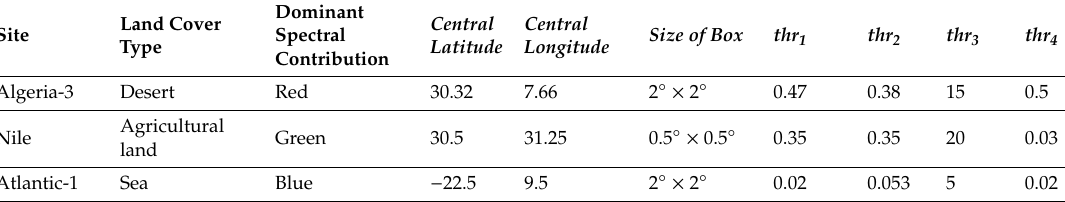
Table 4. Evaluation sites where band-adjusted (homogenised) time series were generated along with spectral characteristics and thresholds for the filtering of SCIAMACHY